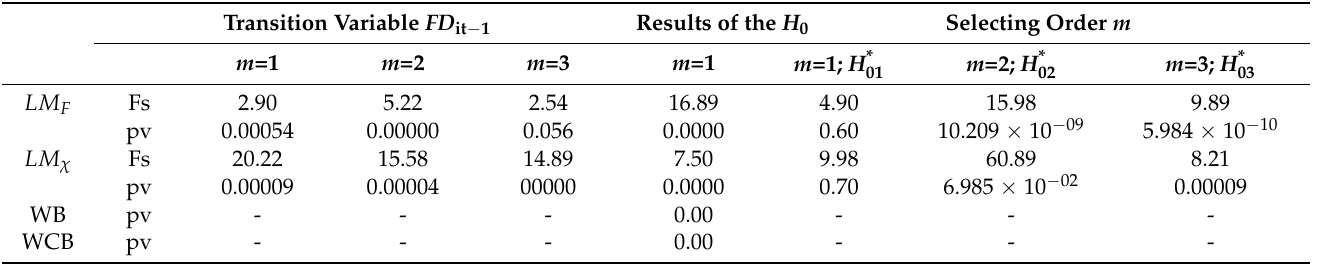
Table 1. Results of selecting the transition